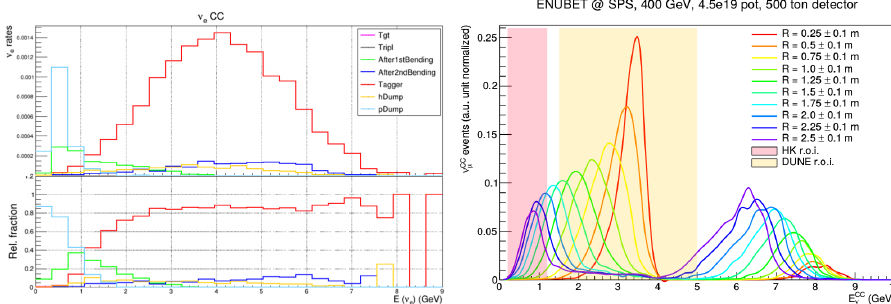
Figure 1. Left top: energy spectrum for ν e CC interactions in a detector of 500 ton mass and 6 × 6 m 2 transverse size placed 50 m from the decay tunnel end. Each color corresponds to a neutrino contribution produced within a region of the beamline. Left bottom: relative fraction of each category with respect to the total ν e CC rate. Right: ν µ CC energy spectra for di ff erent values of distance (R) between the neutrino interaction vertex and the beam axis